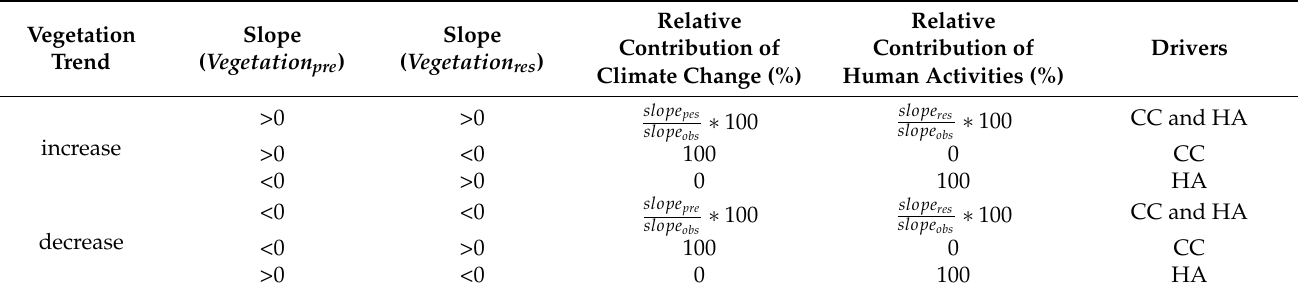
Table 1. Methods for assessing the contribution of climate change and human activities to the variation in vegetation